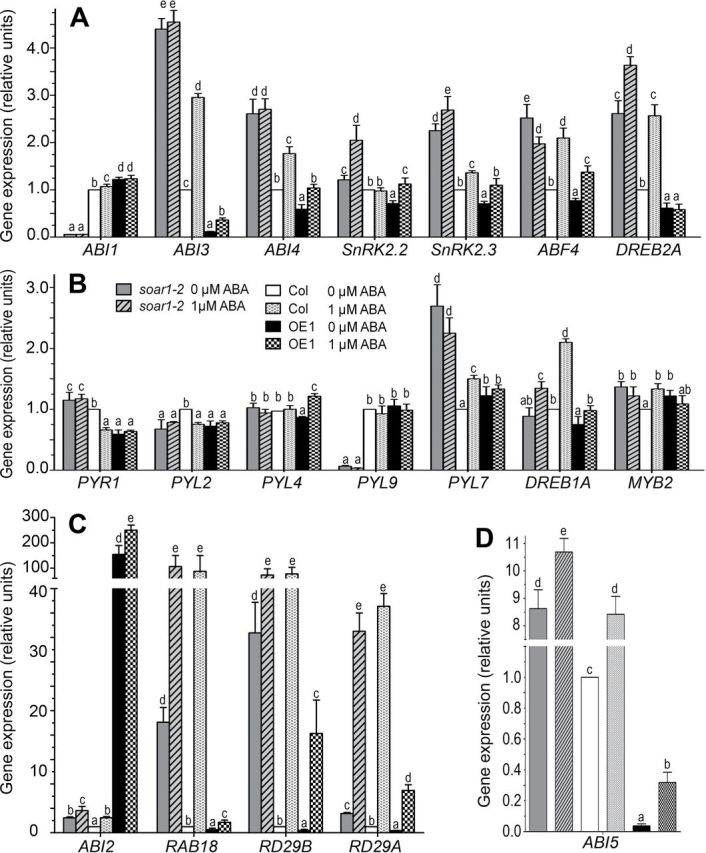
Down- or up-regulation of SOAR1 alters expression of a subset of genes involved in ABA signalling. The RNA sample was extracted from the germinating seeds 24h after a 3 d stratification, and the gene expression levels were analysed by quantitative real-time PCR (A–D). The gene expression levels were relative units normalized relative to the value from the sample of the wild-type Col plants (as 1). Each column is the same in all panels, and a key is provided in B. Each value is the mean ±SE of three biological determinations, and different letters indicate significant differences at P<0.05 (Duncan’s multiple range test) when comparing the expression levels for the same gene among different genotypes treated with the ABA-free (0 μM) or 1 μM ABA-containing solution.